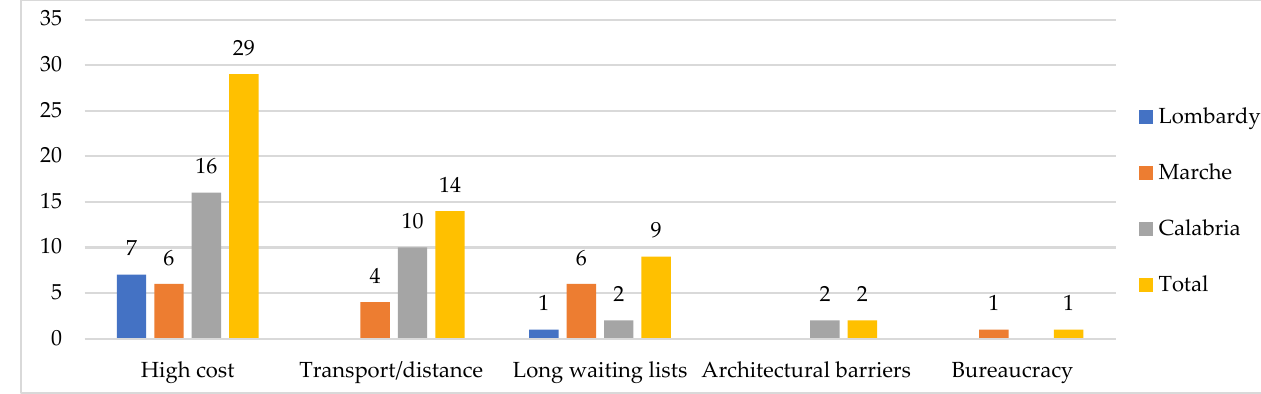
Figure 5. Barriers for using private health services, by region (n). Some respondents reported more than one type of listed barriers.